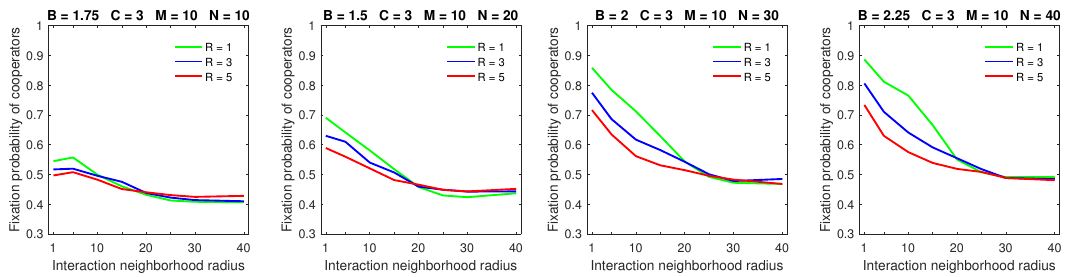
Figure 6. Increasing the dispersal range for high mobility rate M = 10 has a significant negative effect on the fixation probability of cooperators in sufficiently large populations with small-to-medium interaction neighborhoods in the deterministic dispersal model. The flattening effect is lower than in the probabilistic and almost deterministic dispersal models.